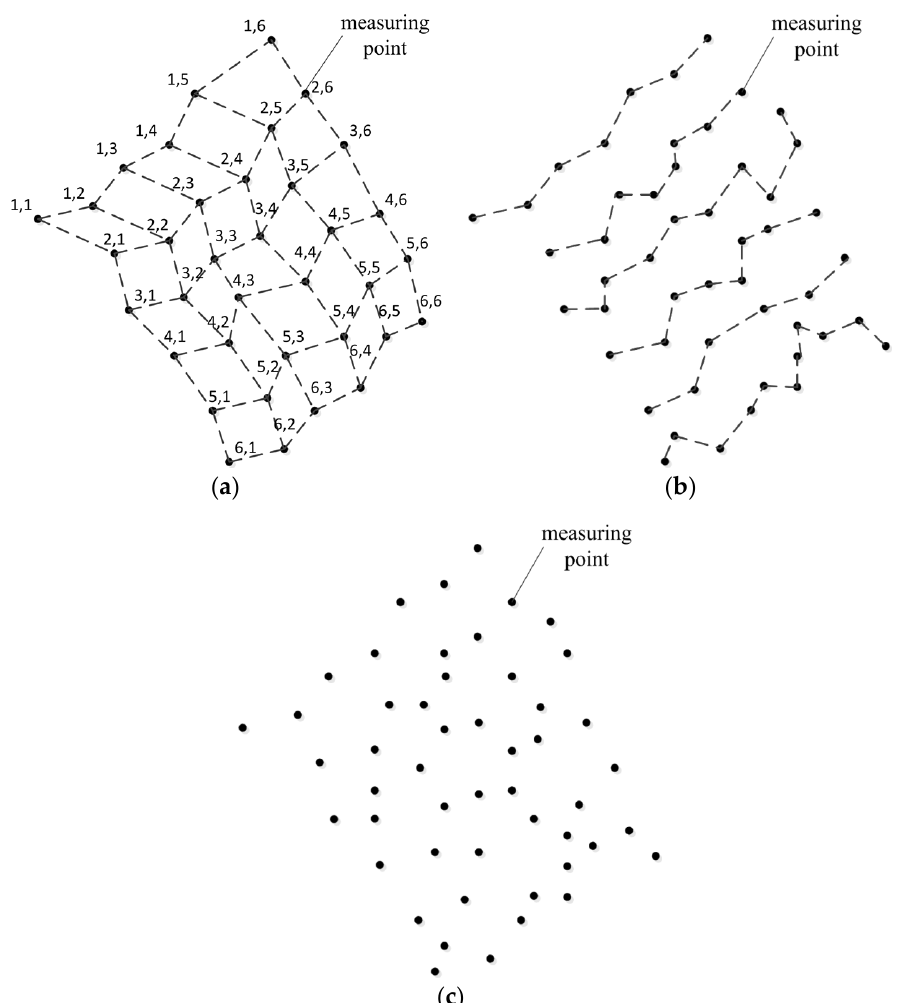
Figure 1. Three different kinds of distribution of data points: ( a ) grid data; ( b ) quasi-scattered data; ( c ) completely scattered data (quasi-scattered data is stored according to the order of measurement which is the main difference from completely scattered data).